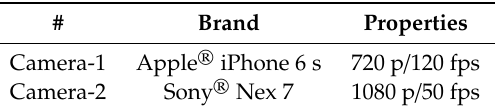
Table 1. Specifications of the cameras.